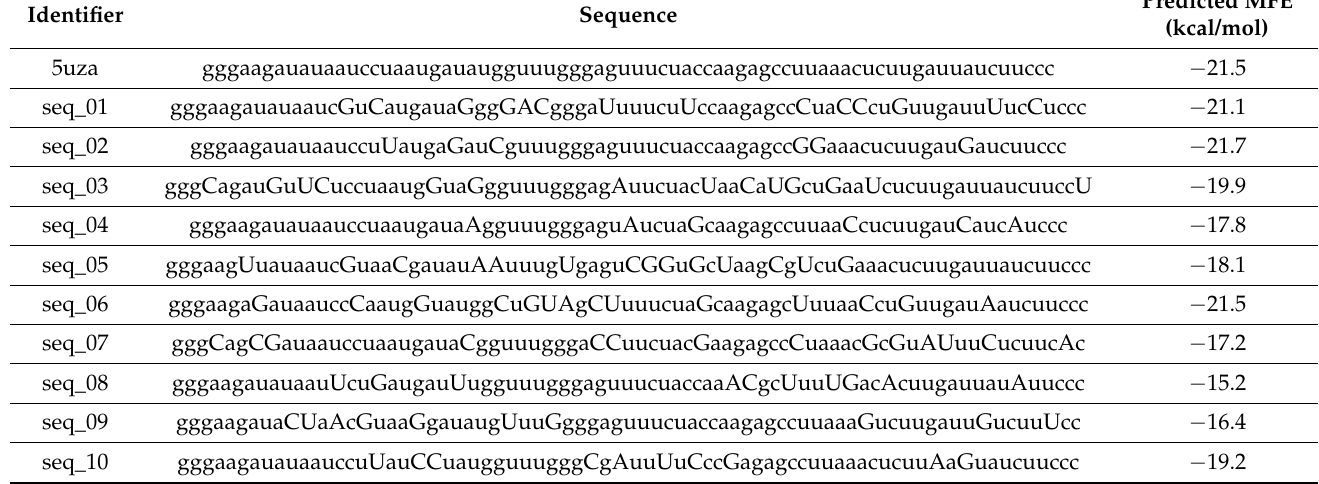
Table 3. Newly generated sequences. Capital letters are the modified